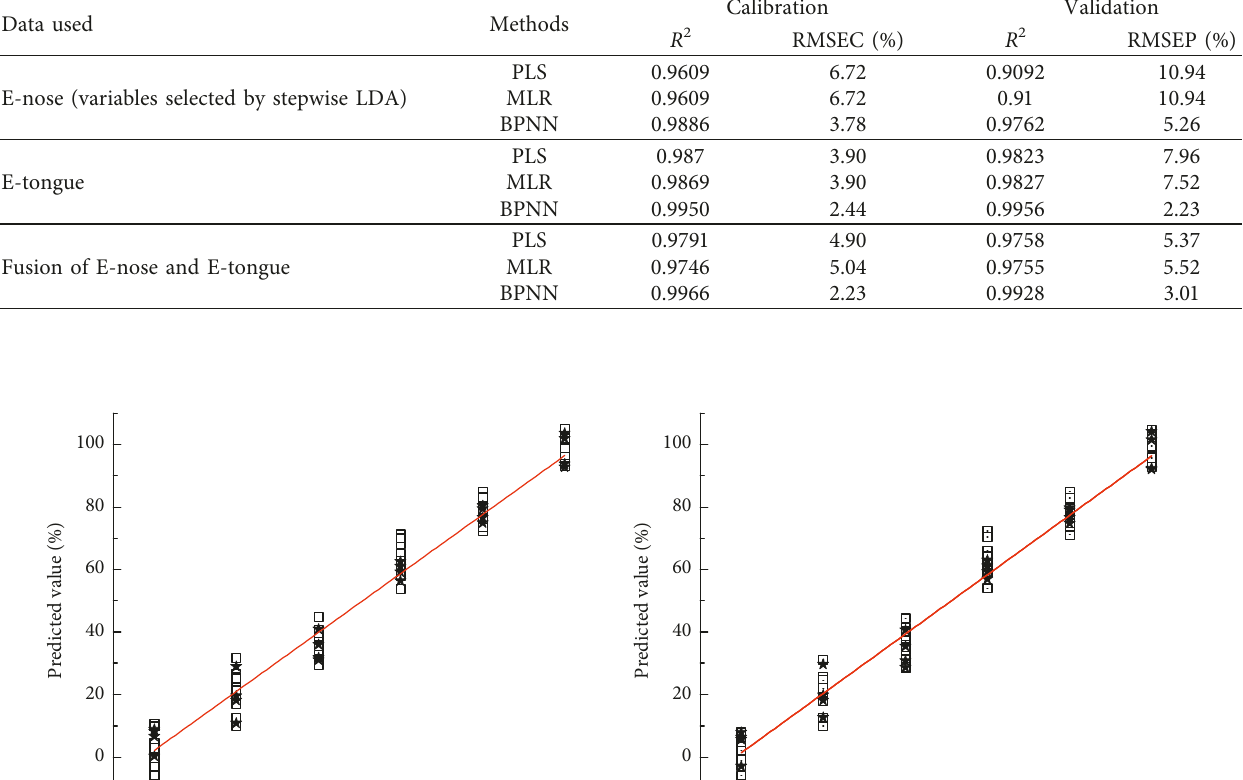
Table 6: Prediction of pork proportion in minced mutton by signals of E-nose, E-tongue, and the combined data set of E-nose and E-tongue.